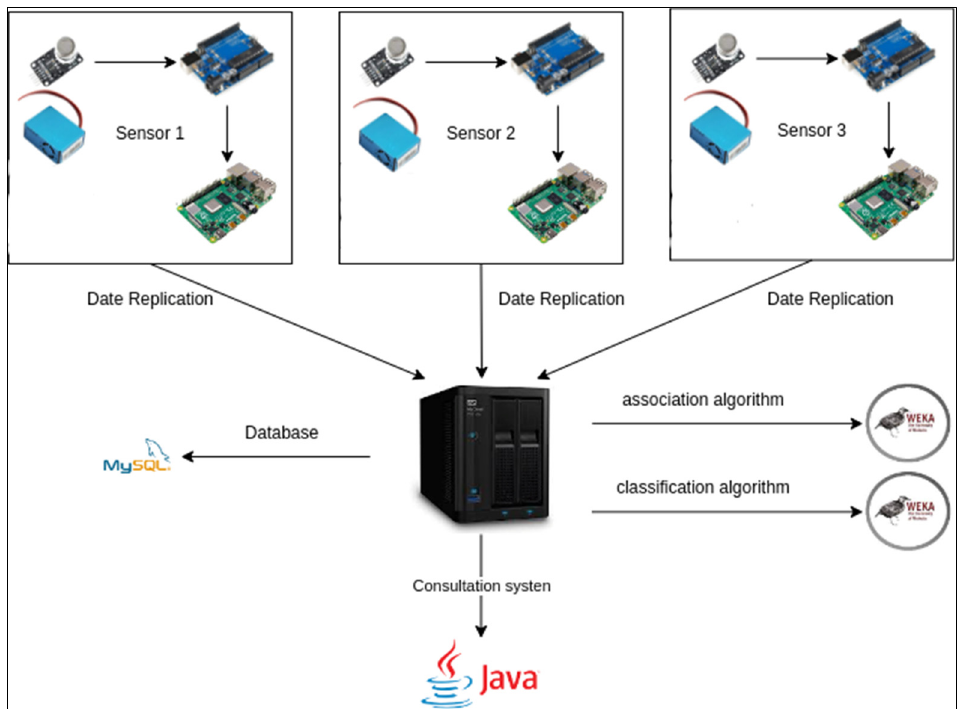
Figure 1. Measurement flow for the architecture of the CO 2 and PM monitoring platform.